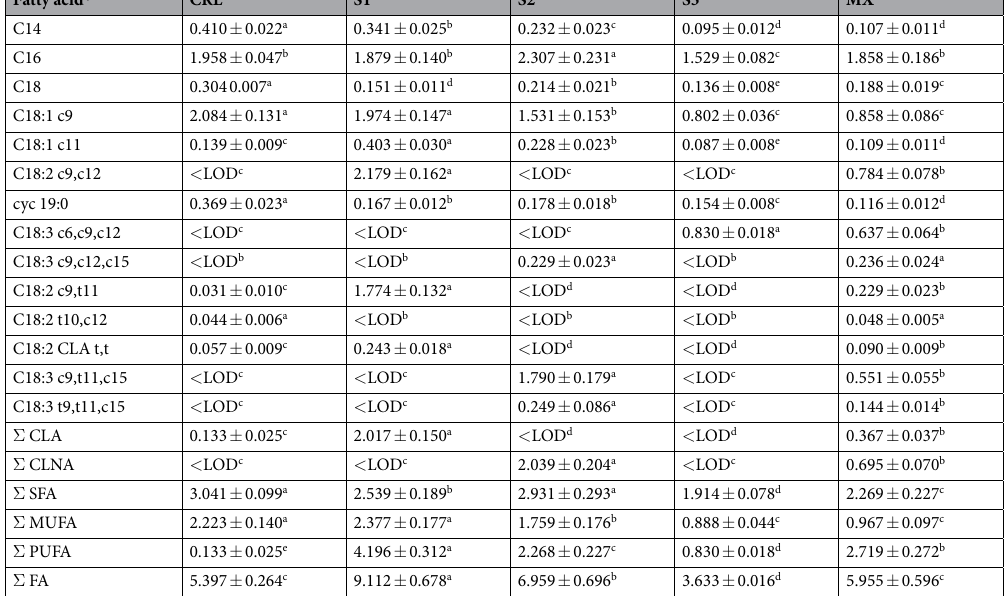
Table 1. Fatty acid composition ( µ g/mg) of pellets from B. breve NCIMB 702258 after 24 h of incubation in cys-MRS culture medium control (CRL) and with 0.5 mg/mL of LA (S1), α -LNA (S2), γ -LNA (S3) and LA + α -LNA + γ -LNA (1:1:1; MX). * Average value ± standard deviation (n = 3). a,b,c,d,e Different superscript letters within a row for significant differences (p < 0.05). c = cis double bound; t = trans double bound; cyc = cyclopropane fatty acid; Σ = total; CLA = conjugated linoleic acid; CLNA = conjugated linolenic acid; SFA = saturated fatty acids; MUFA = monounsaturated fatty acids; PUFA = polyunsaturated fatty acids; FA = fatty acids; < LOD = below limit of